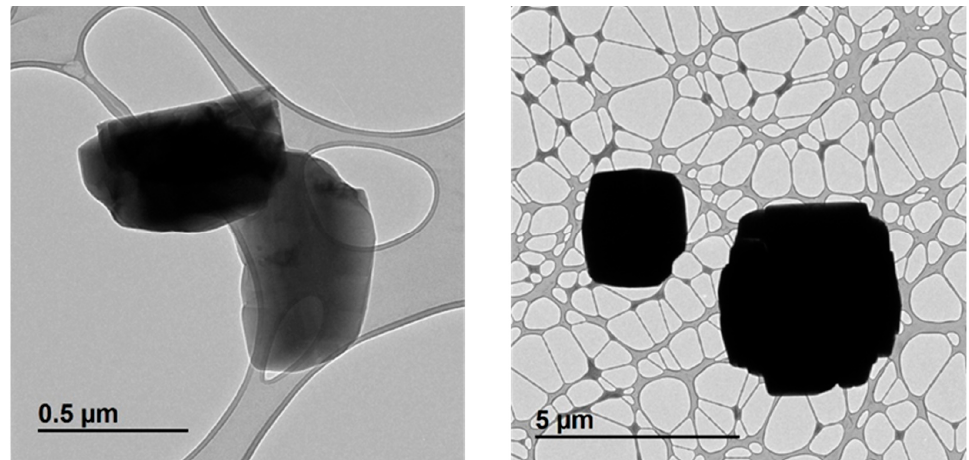
Figure 4. TEM micrographs of Vaterite at different magnifications.